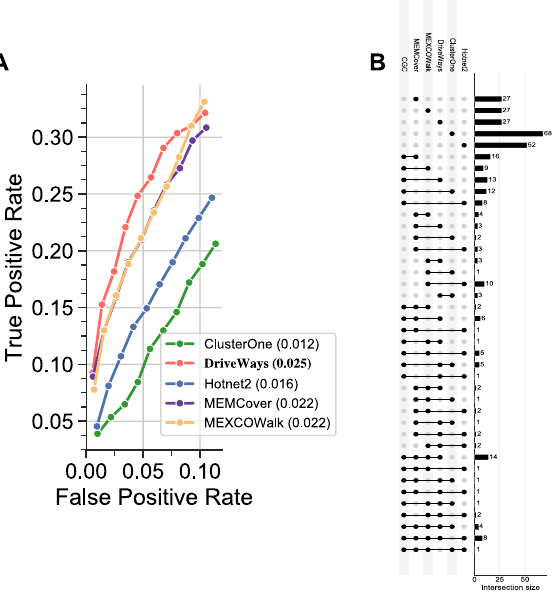
Figure 1. ( A ) ROC curves calculated for unique_genes = 100, 200, . . . , 1000 from the output sets of modules of the methods under consideration. ( B ) Upset graph visualization of overlaps in the sets of top 100 genes output by the methods under